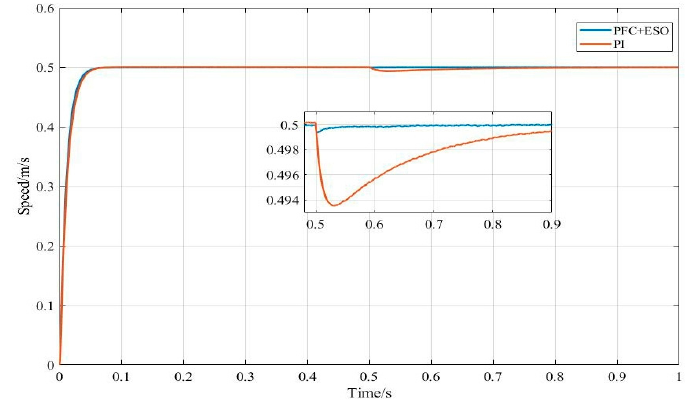
Fig. 4 Figure 4. Performance comparison between PI and predictive function control (PFC) + extended state